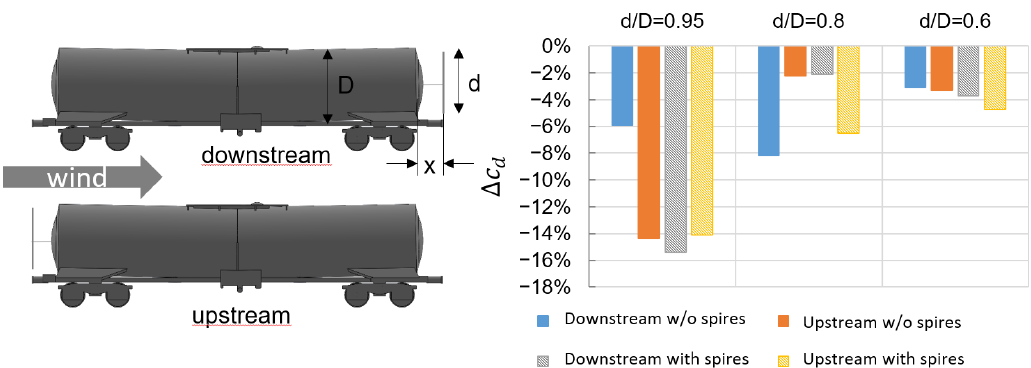
Figure 9. Mounted inter-wagon discs ( left ) and drag reductions for different diameters ( right ).